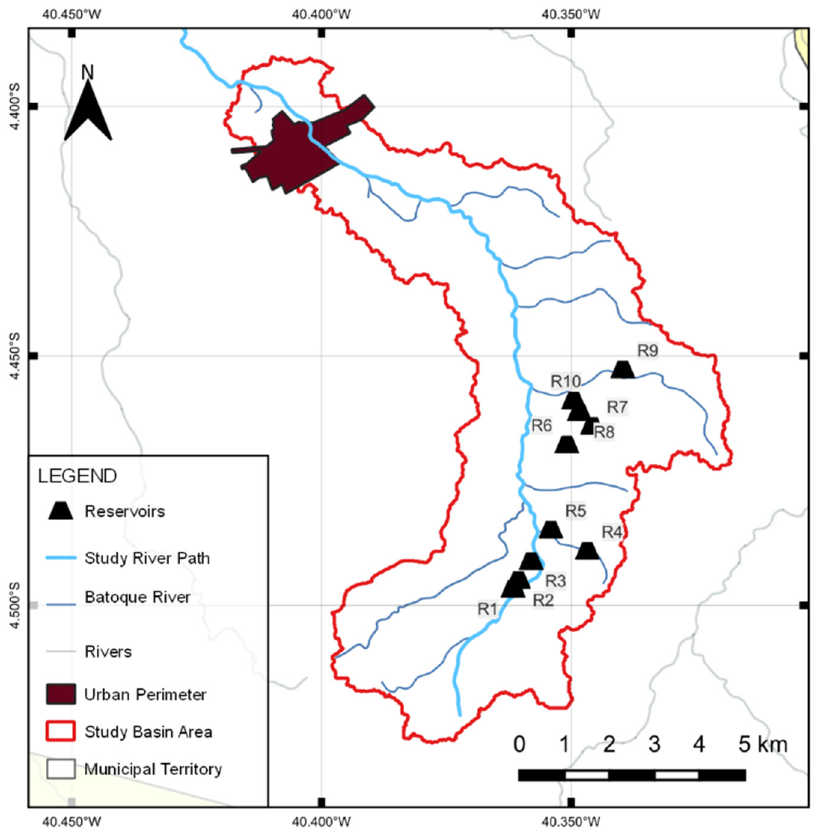
Figure 6. Map of locations of the broken dams.